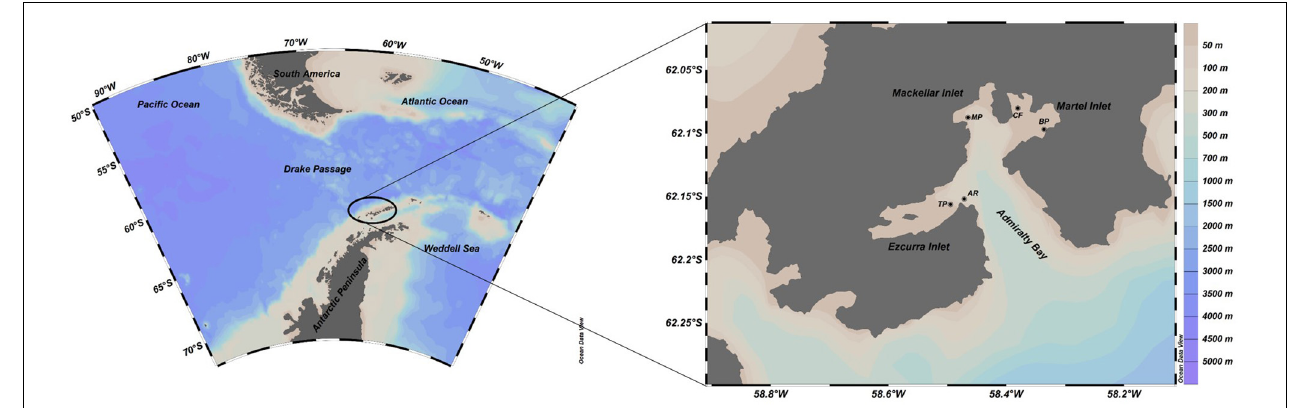
FIGURE 1 | Study area in Admiralty Bay (enlargement) off the King George Island in South Shetland Islands, Antarctica. Black dots denote sampling stations. CF, Comandante Ferraz; BP, Botany Point; MP, Machu Picchu; TP, Thomas Point; AR, Arctowski.